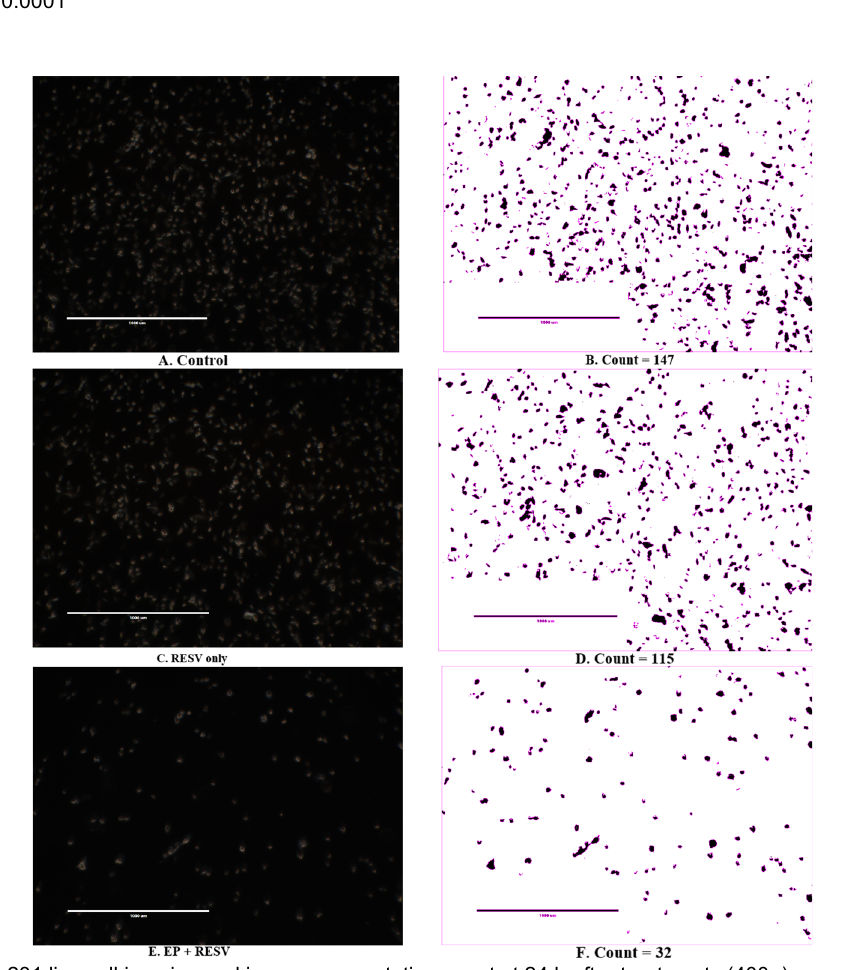
Explor Target Antitumor Ther. 2023;4:42–56 | https://doi.org/10.37349/etat.2023.00122